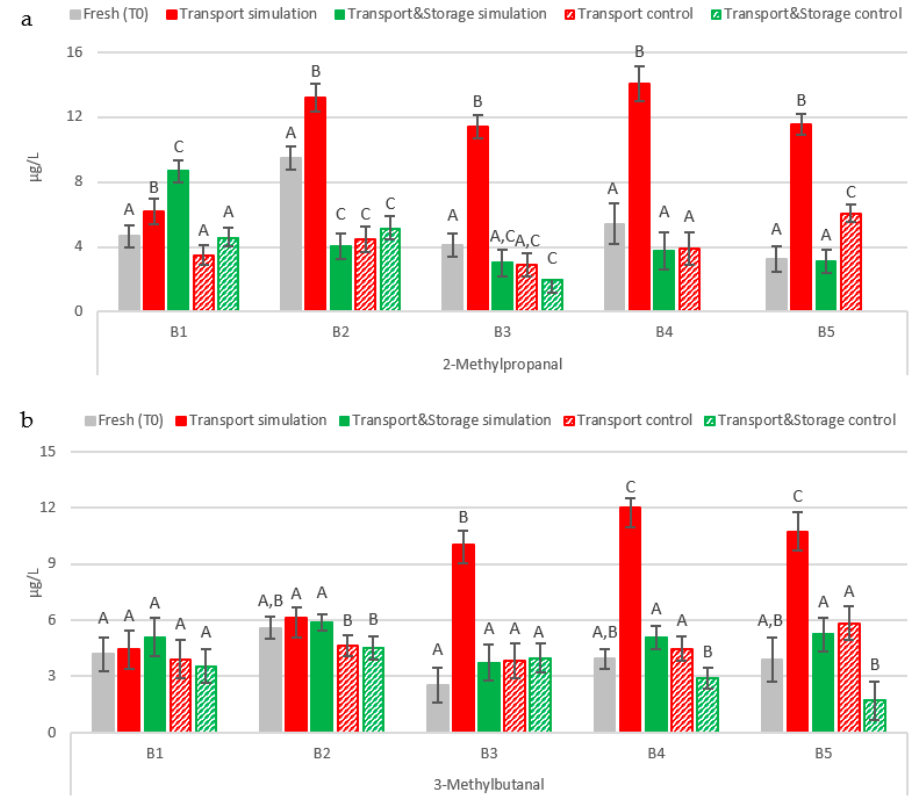
Figure 2. Evolution of Strecker aldehydes under simulated conditions: ( a ) 2-methylpropanal; ( b ) 3-methylbutanal. The Tukey test was performed for each batch. Different letters represent statistically significant differences ( p < 0.05).